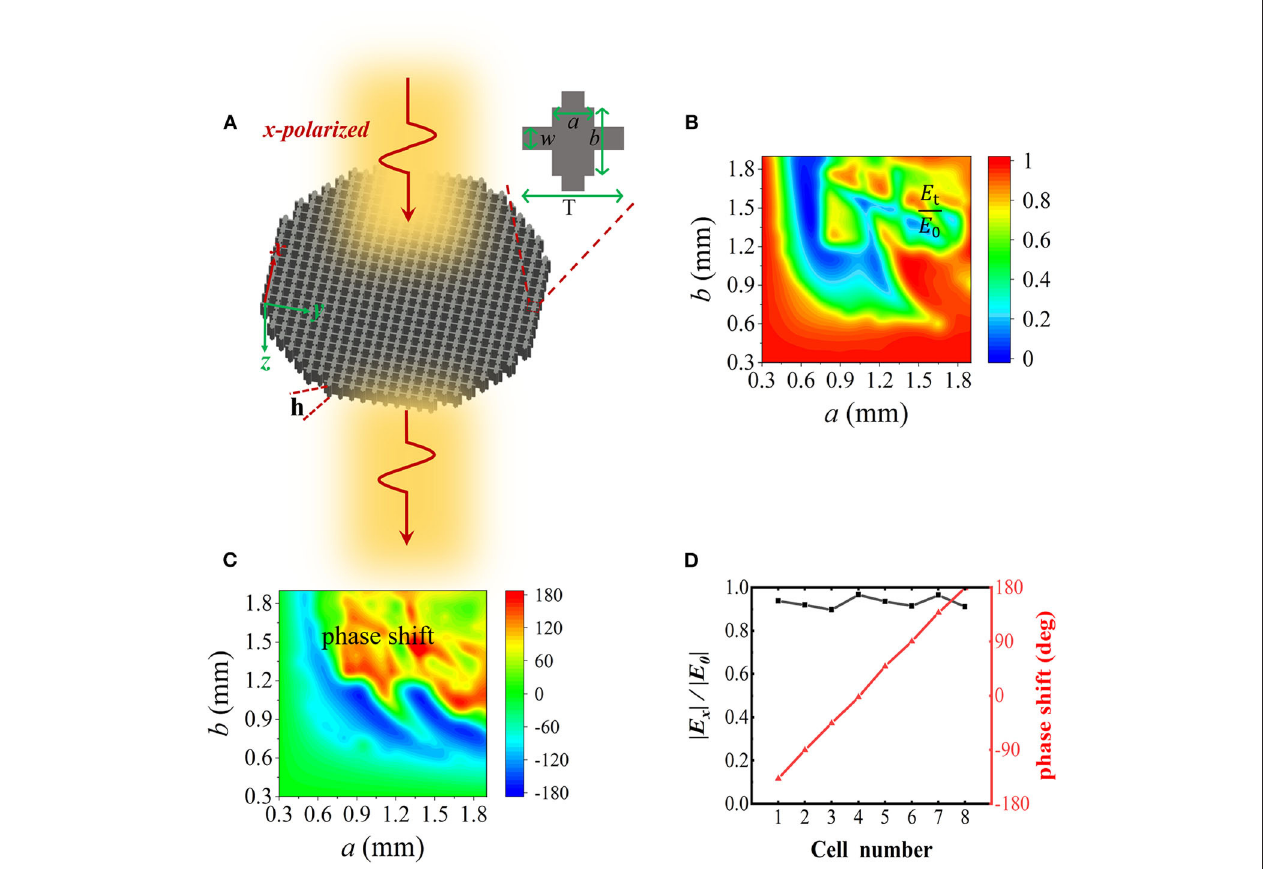
FIGURE 1 | Proposed dielectric metasurface and the control characteristics of metasurface unit cells. (A) Schematic of the proposed metasurface. The inset shows a basic unit cell of the metasurface. (B,C) Amplitude transmission and corresponding phase shift, respectively, of x -polarized wave with a frequency of 0.14 THz. (D) Phase shift and amplitude transmission for the selected eight unit